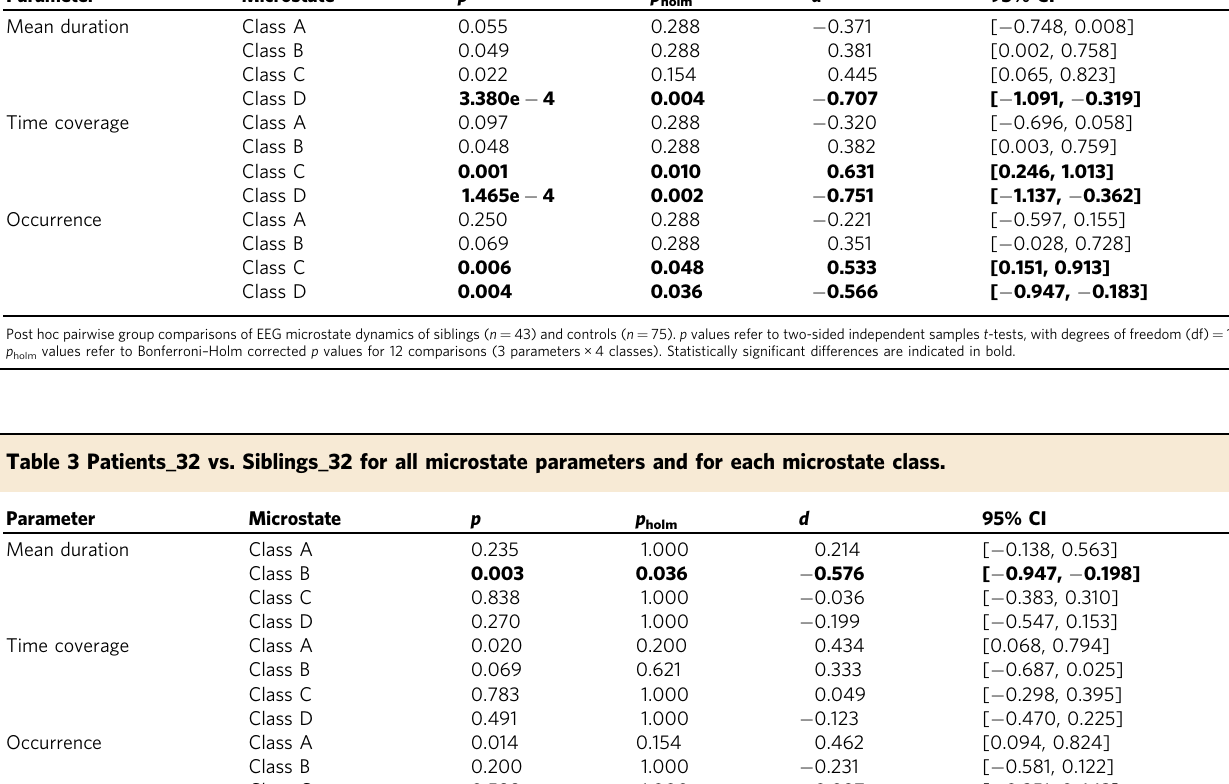
microstates parameters. No statistically signi fi cant group differ- ences were found for microstate class A.